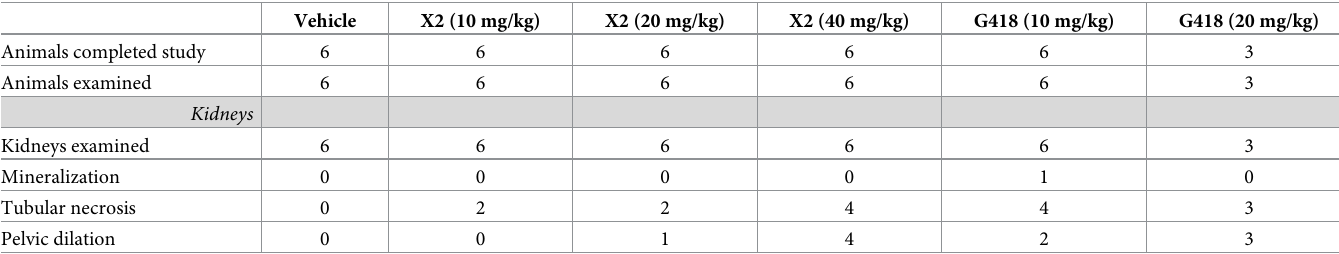
Table 4. Rat kidney